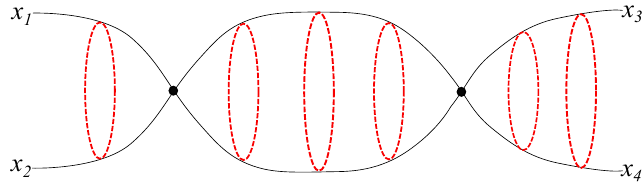
Figure 13 . Feynman diagrams contributing to the four-point function G 0 ( x 1 ; x 2 j x 3 ; x 4 ). Dots denote double-trace (cid:11) 2 vertices, all other quartic vertices describe single-trace (cid:24) 2 coupling. 1